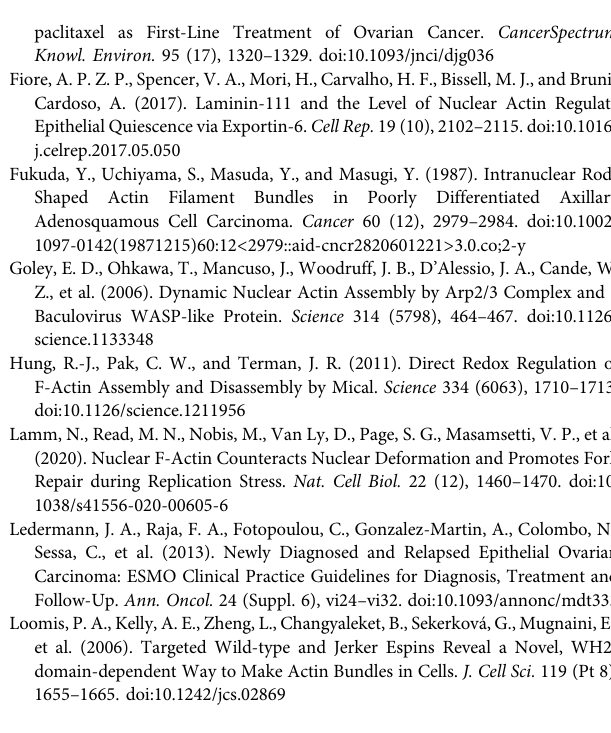
Supplementary Figure S1 | (A-C) , Quanti fi cation analysis of nuclear F-actin in OVCA432-nAc-citrinecells. (A) ,ThicknessofnuclearF-actin. (B) ,Numberofnuclear F-actin per cell. (C) , Length of nuclear F-actin. (D) , Saturation analysis indicating the sequencing coverage. (E) , Differentially expressed genes between OVCA432-nAc- citrine cells and OVCA432 cells are shown in volcano plots, in which the signi fi cantly up-regulated genes (log2FC > 1 and q-value < 0.05) are marked in red, and the signi fi cantly down-regulated genes (log2FC < -1 and q-value < 0.05) are marked in blue. Supplementary FigureS2 |(A) ,PAX8stainedinaseparate frozen tumour section. Green, PAX8. Blue, DAPI. Scale bar, 20 μ m. (B-C) , Nuclear F-actin staining in a frozen tumoursection from thesamepatientas inFig.1 I. Red, F-actin stainingusing rhodamine-phalloidin.Blue,DAPI.Thewhiterectanglewasmagni fi edinC.Scalebar (in B), 10 μ m. (D) , Reslice analysis of a tumour cell (left panel) and rhodamine- phalloidin signal (red) in the nucleus (blue) (right panel). (E) , Negative control for Reslice analysis (left panel) and a cell without nuclear F-actin due to the absence of rhodamine-phalloidin signal (right panel). Supplementary Figure S3 | (A) , Reported targets of the top 15 small molecule inhibitors that reduced nuclear F-actin polymerization in ovarian cancer cells. (B) , Reportedtargetsofthetop5smallmoleculeinhibitorsthatincreasednuclearF-actin polymerization in ovarian cancer cells. Supplementary Video S1 – S3 | Time-lapse movies show representative examples of nuclear F-actin organization of SKOV3-nAc-citrine cells. The movies were generated using images captured by high-content screening. Images were recorded every 5 mins and the movies were displayed with 10 frames per second to show the nucleus F-actin status for approximately 42 h. Green, nAc- citrine. Supplementary Video S4 | Imaris-modelled 3D structure of the nucleus from Figure 1J showing that the actin fi laments localize in the nucleus. Red, rhodamine- phalloidin. Blue,